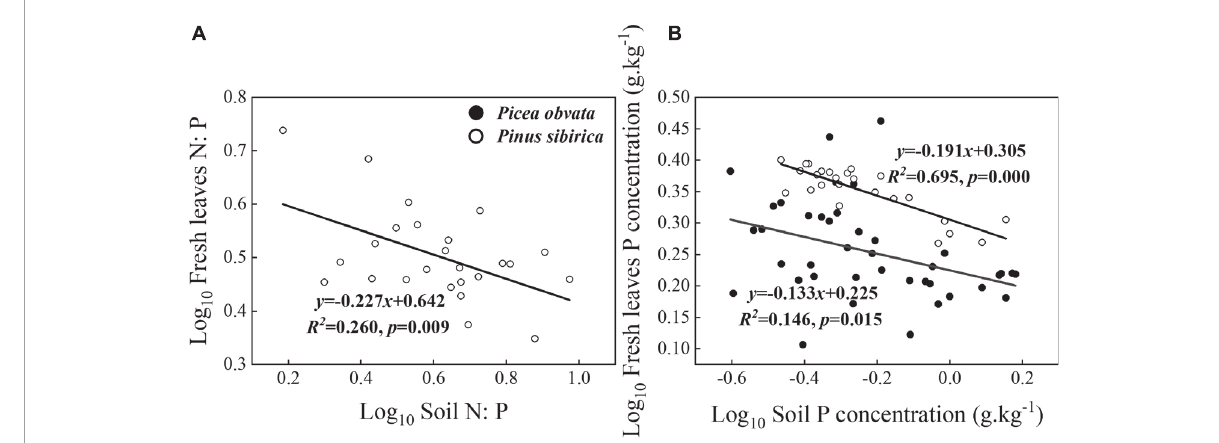
FIGURE6 Relationships between fresh leaves and soil P concentrations in PS (A) , and N: P in PS (B) and PO.